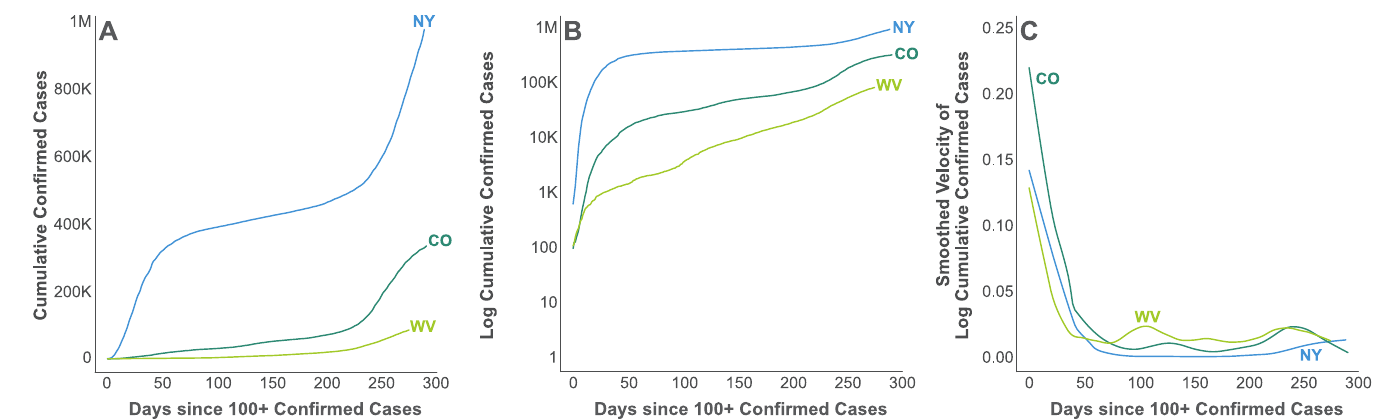
Fig 1. Log cumulative cases and its velocity. The cumulative case count (a), the log cumulative confirmed case count (b) and its velocity (c), i.e., first derivative with respect to time, for three example states, New York (NY), Colorado (CO), and West Virginia (WV) since 100 or more confirmed cases were